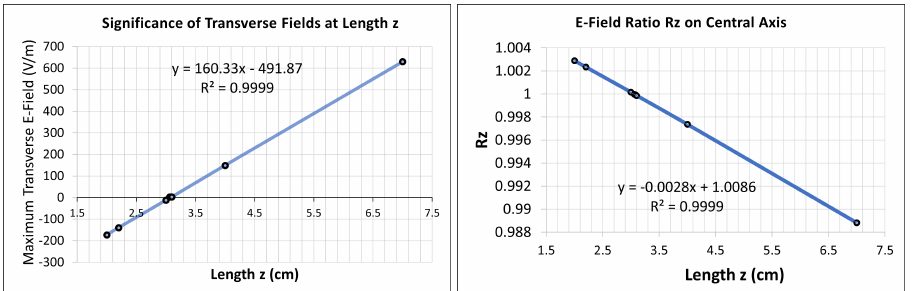
Figure 12. Plots showing the disappearance of residual fields in the TPC for a value of z o ∼ 3.06 cm. Simulated TPCs used 100 voltage strips, had an unperturbed length of 5 m, and used a strip width of 4